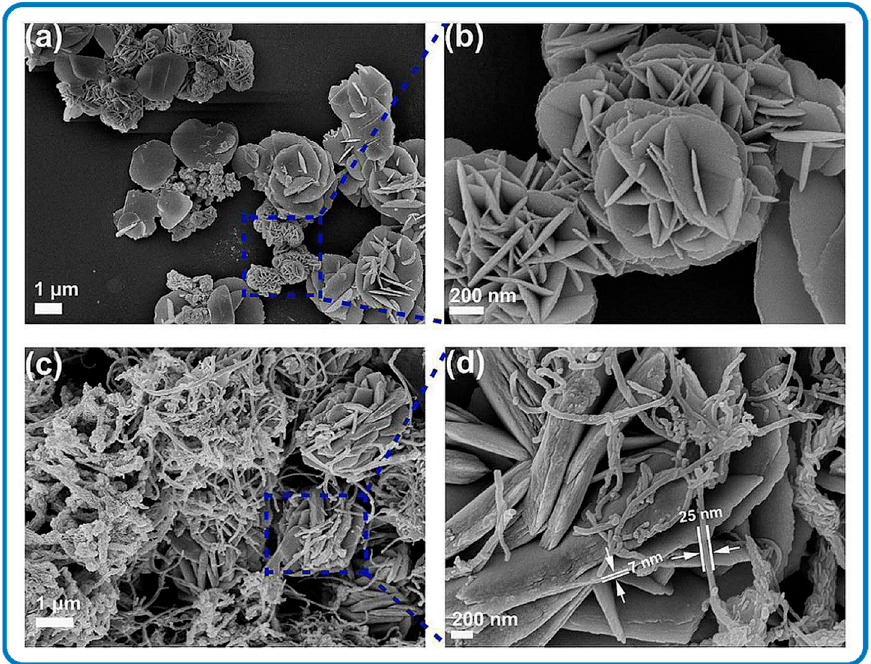
Figure 12. SEM images of ( a , b ) SnS 2 and ( c , d ) SnS 2 /CNTs. Reproduced with permission from [111]. Copyright 2016, Elsevier.